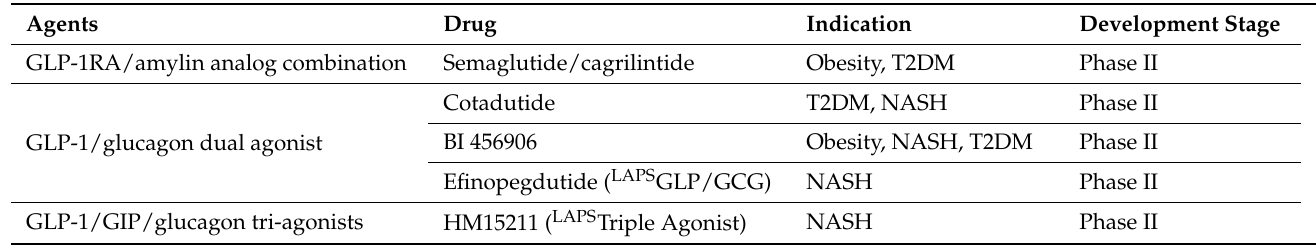
Table 2. A list of novel therapies for obesity and diabetes consisting of GLP-1-based multi-agonists.